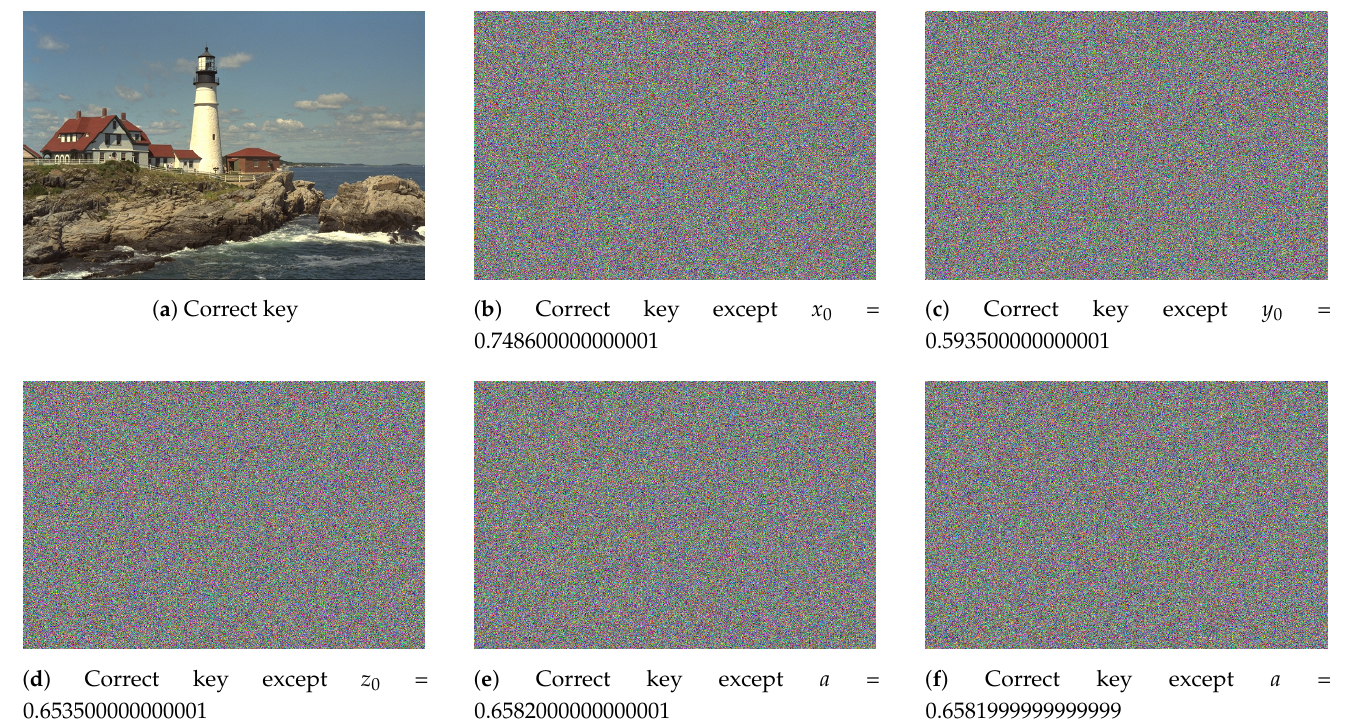
Figure 8. Outcomes of key sensitivity for the proposed image